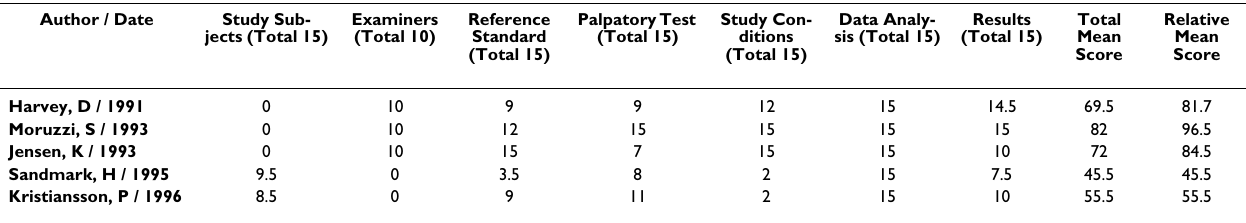
Table 4: Average Quality Scores given in each of the 7 major criteria and the total and relative scores for each included article. Author /